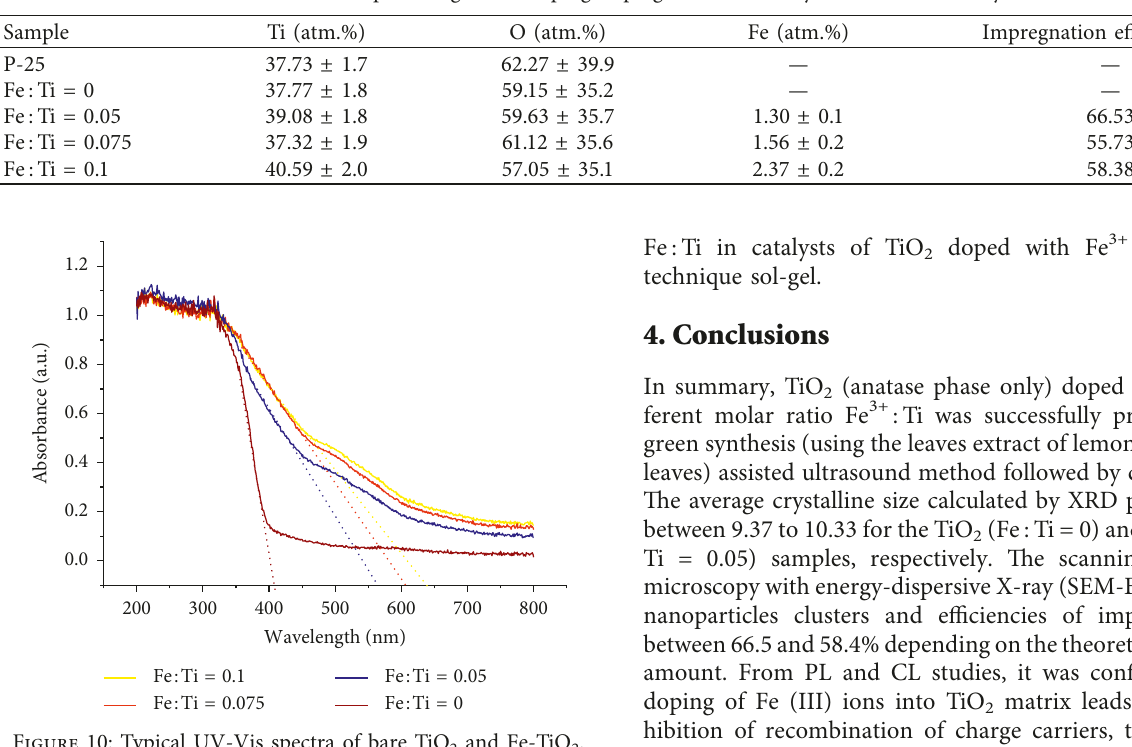
Figure 10: Typical UV-Vis spectra of bare TiO